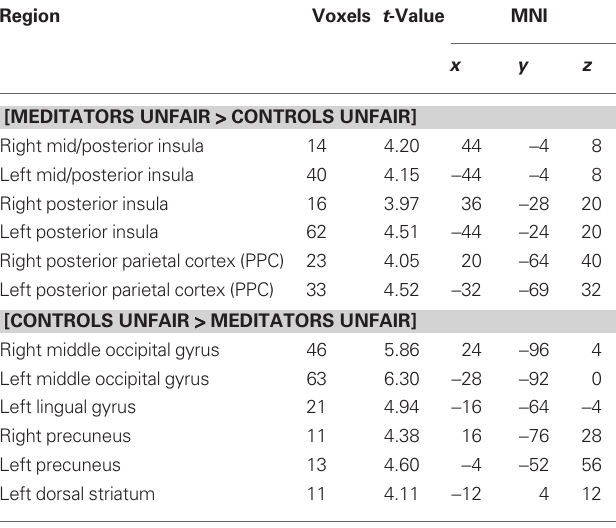
Table 1 | Between-group main effects of unfair offers for human